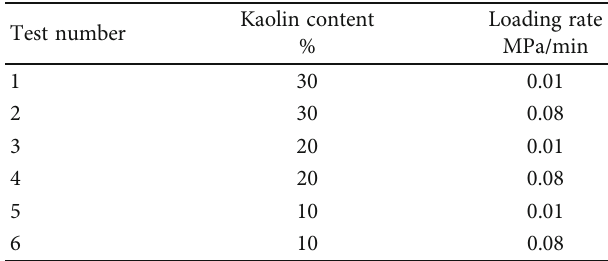
Figure 3: A large-scale triaxial stress-seepage test system. Table 3: Test